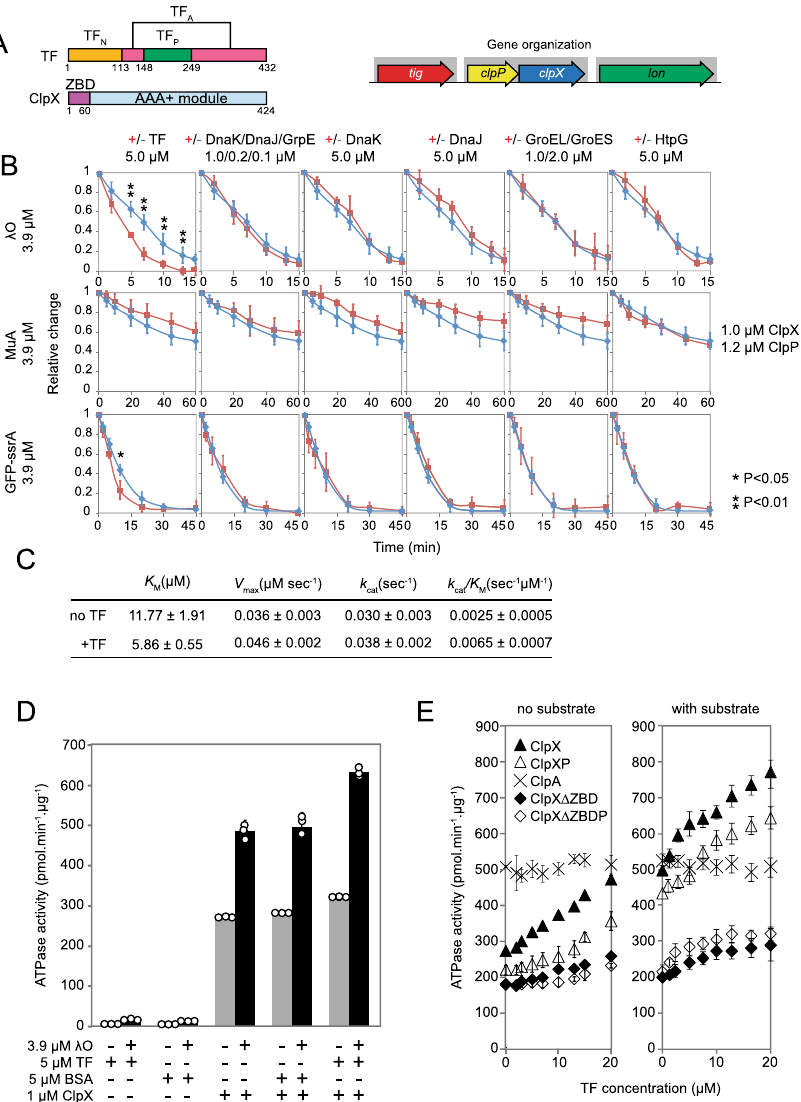
Fig. 1 The effect of chaperones on the ClpXP-mediated degradation of model substrates. A Domains in E. coli ClpX and TF proteins (left panel) and the genetic localization of the tig , clpPX and lon operons in E. coli (right panel). B Kinetics of the degradation of model substrates by ClpXP in the presence (red) or absence (blue) of different chaperones. Shown are examples of at least three repeats; data are presented as mean values and error bars represent standard deviations. Student ’ s two-tailed t test was used to compare each time point. C Michaelis – Menten values derived from Supplementary Fig. 3c based on the change in the ClpXP-dependent degradation rates upon increasing concentrations of λ O substrate. D Shown is the ATPase activities of ClpX in the absence and presence of λ O substrate, TF, or BSA control. All reactions were background-subtracted and repeated at least three times to obtain the averages and standard deviations. ClpP is absent in these reactions. E The ATPase activities of ClpX and ClpX Δ ZBD in the absence or presence of λ O substrate and increasing concentration of TF. The effect of TF on the ATPase activity of ClpA is shown as a control. Error bars represent the standard deviations from n = 3 independent replicates. Source data are provided as a Source Data fi